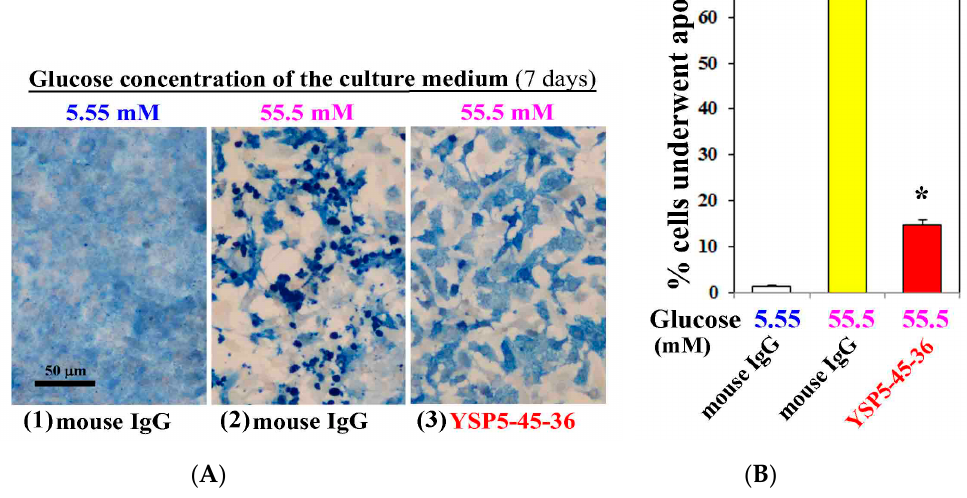
Figure 3. Anti-ORAIP mAb mostly suppressed high glucose-induced apoptosis in cultured cardiac myocytes in vitro. ( A ) Induction of apoptosis in cardiac myocytes as determined by TUNEL staining (brown) and cardiac myosin immunostaining (blue). Representative images at seven days by treatment with high glucose and mouse IgG or anti-ORAIP mAb (YSP5-45-36) (0.05 g/L). Bar, 50 μ m; ( B ) The percentage of apoptotic cardiac myocytes, as determined by TUNEL staining, induced by treatment with high glucose and mouse IgG or anti-ORAIP mAb (YSP5-45-36). The data are expressed as the mean ± SE. ( n = 4 for each). * p < 0.0001 vs. Glucose (55.5 mM) with mouse IgG (Dunnett’s multiple comparison test).